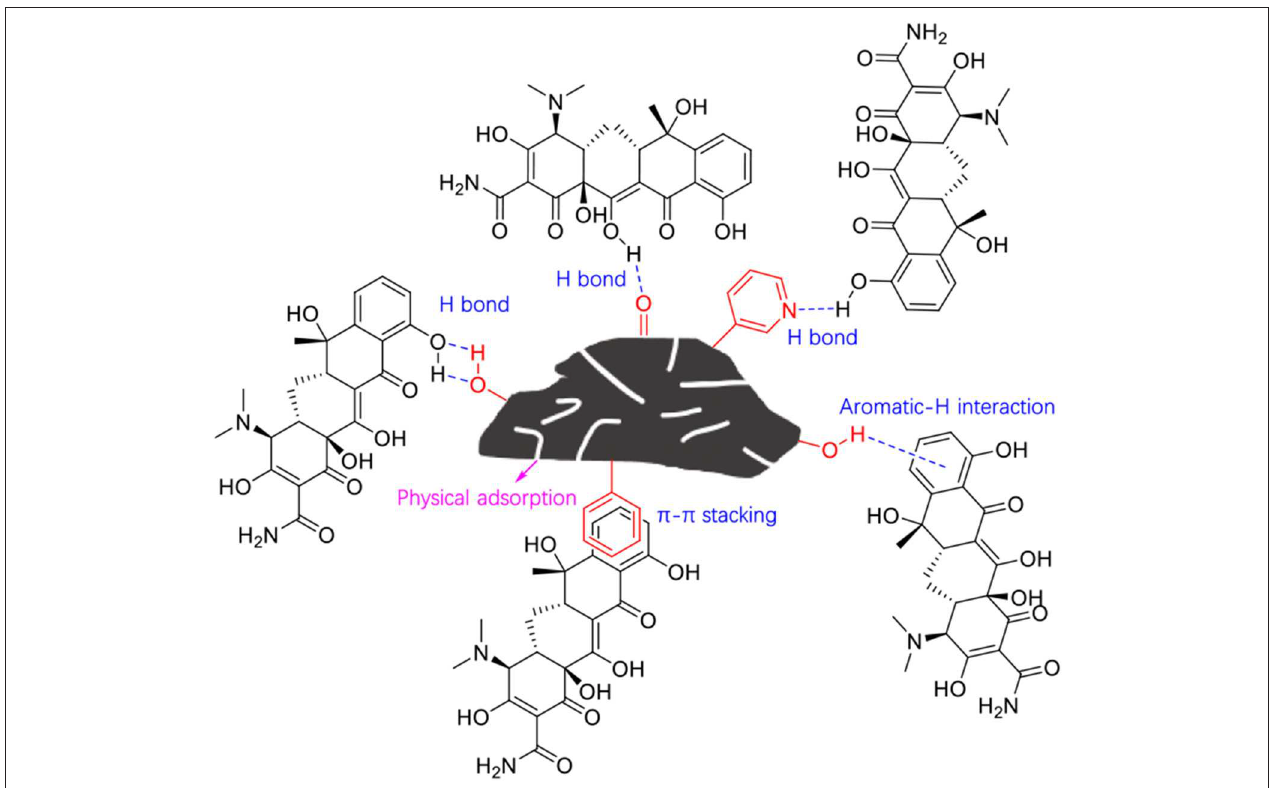
FIGURE 6 | Proposed mechanisms of the adsorption